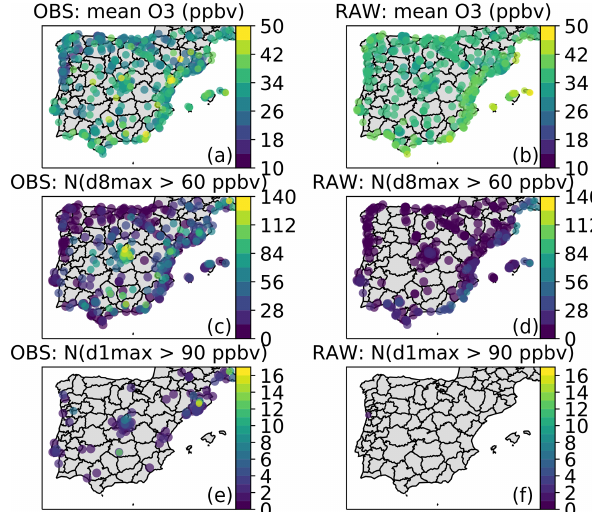
Figure 1. Overview of the O 3 pollution over the Iberian Penin- sula, as observed by monitoring stations (a, c, e) and as simulated by the CAMS regional ensemble D + 1 forecasts (b, d, f) , showing the mean O 3 mixing ratios (a, b) and the number of exceedances of the standard (d8max > 60ppbv; c, d ) and information thresh- old (d1max > 90ppbv; e, f ) over the period 2018–2019. In order to limit the overlap, stations are plotted here by decreasing value and with decreasing size (lowest values with largest symbols but in background, highest values with smallest symbols but in fore- ground). For clarity, the stations without any observed or simulated exceedance are